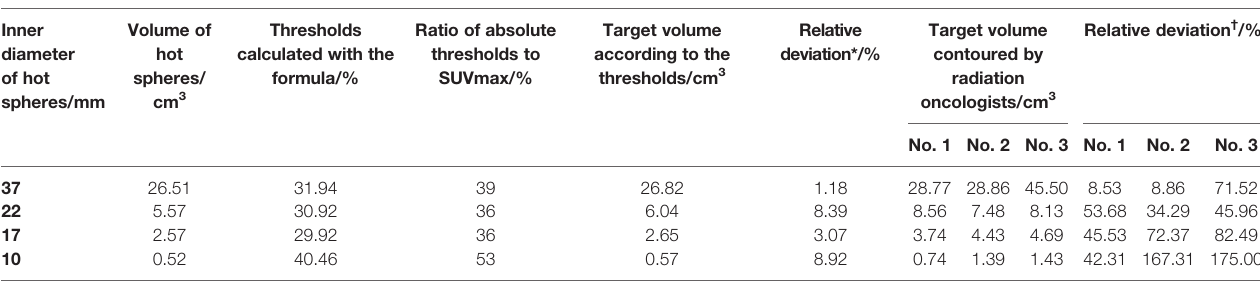
TABLE 2 | Data analysis of the phantom validation